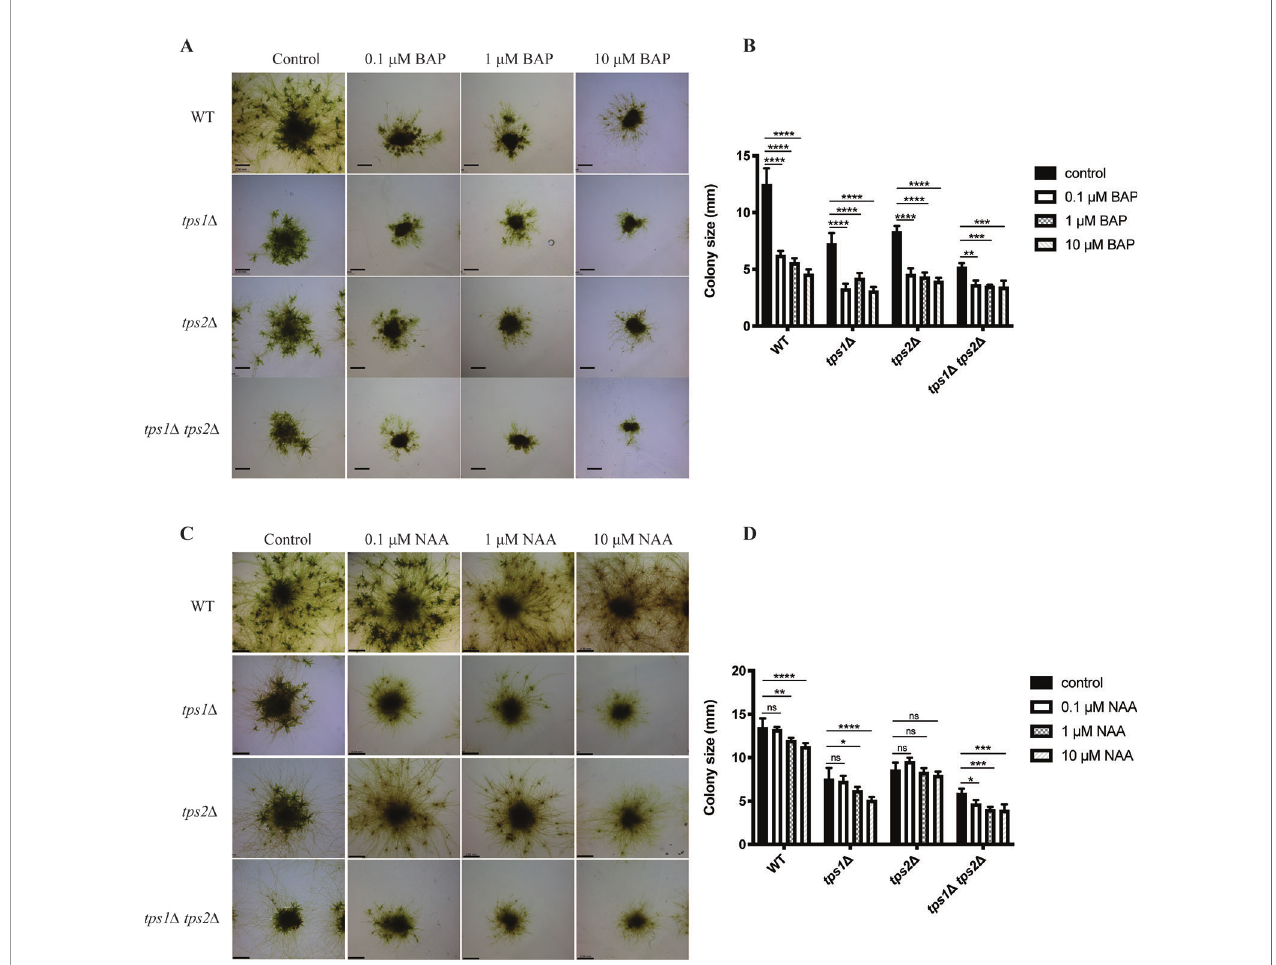
FIGURE 11 | Morphology of wild-type (WT) and transgenic plants grown on different concentrations of cytokinin and auxin. (A) Representative images of protonema morphology of plants grown on plain BCDAT medium (control) or BCDAT medium added with different concentrations of BAP (0.1, 1, 10 µM). Bars represent 2 mm. (B) Measurement of colony size of WT and mutants after 1-month growth on the medium added with BAP. Data represent mean ± SD of four individuals of protonema colonies. (C) Representative of protonema morphology of plants grown on plain BCDAT medium (control) or BCDAT medium added with different concentrations of NAA (0.1, 1, 10 µM). Bars represent 2 mm. (D) Measurement of colony size of WT and mutants after 1-month growth on the medium added with NAA. Data represent mean ± SD of four individuals of protonema colonies. Statistical analysis with two-way ANOVA, *p ≤ 0.05, **p ≤ 0.01, ***p ≤ 0.001, ****p ≤ 0.0001, ns, no signi fi cant